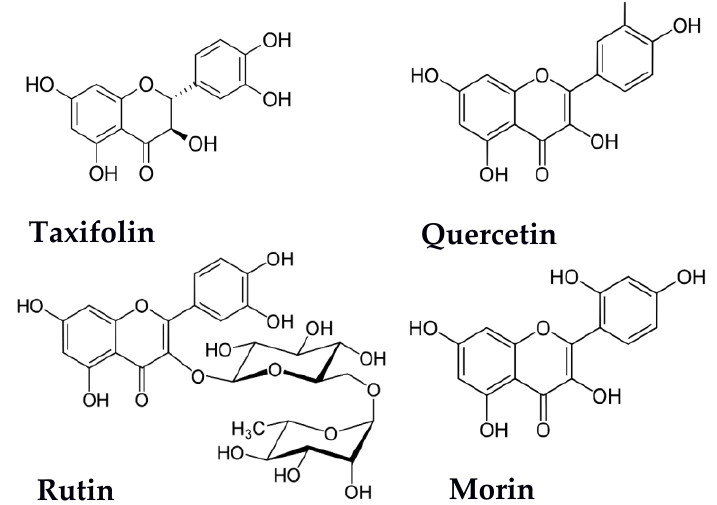
Figure 1. Structures of flavonoids; components of the studied combinations.